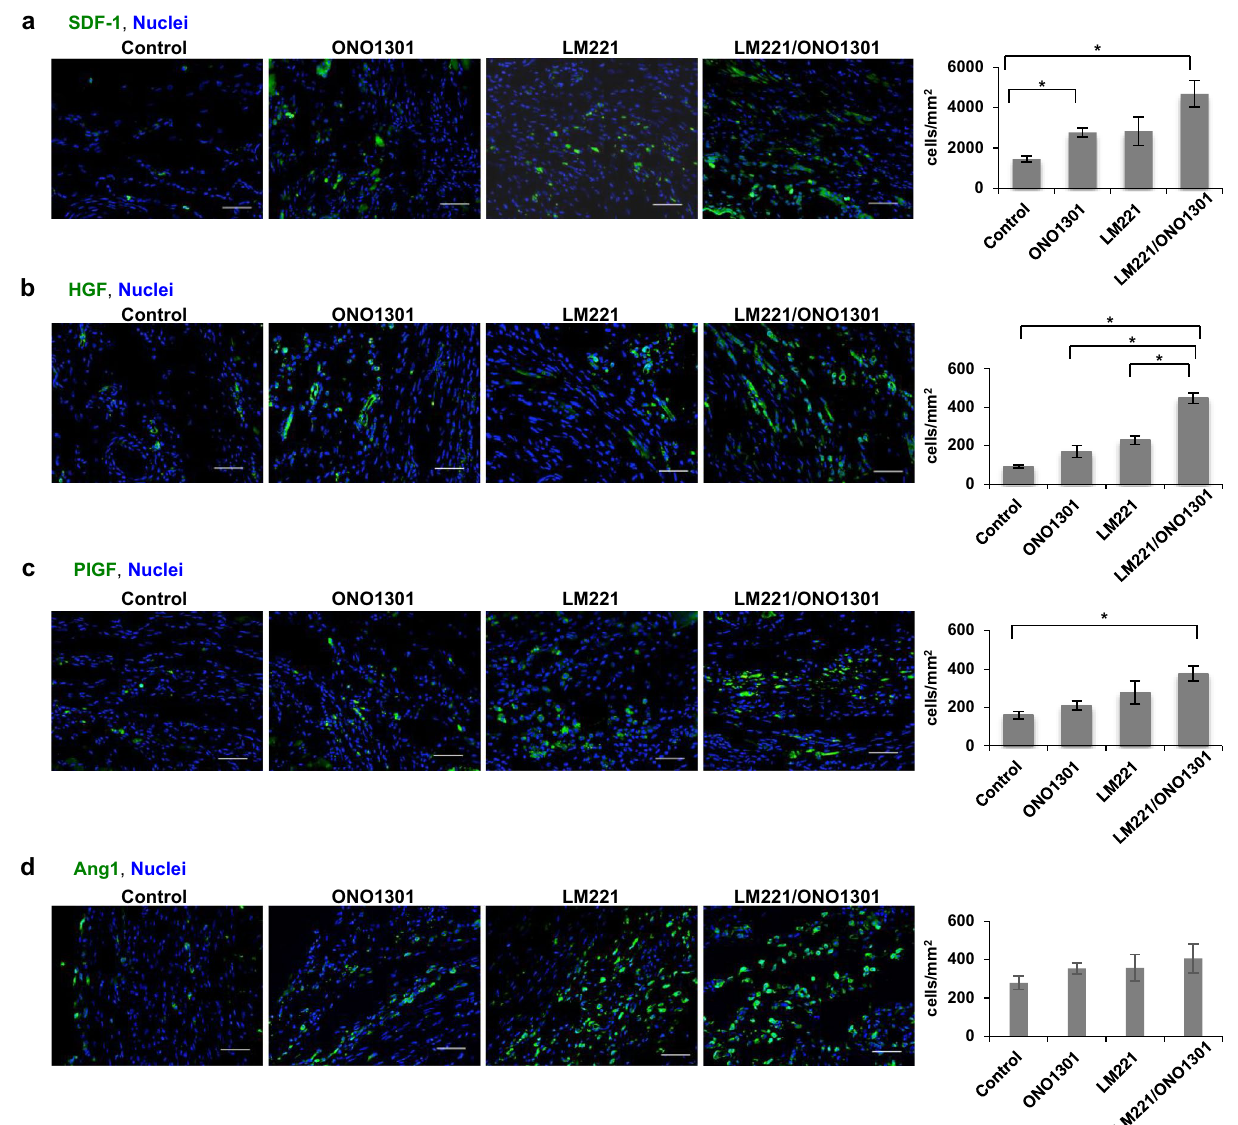
Figure 2. Combined administration of LM221 and ONO1301 induced chemotactic cytokine and angiogenic cytokine production. The protein expression of ( a ) SDF-1, ( b ) HGF, ( c ) PIGF, and ( d ) Ang1 in the implanted site was measured by immunohistochemistry. Representative microscopic images show cytokines (green) and nuclei (blue). Scale bar = 50 μm. The graph indicates the number of cytokine-positive cells at the implanted site. * p <